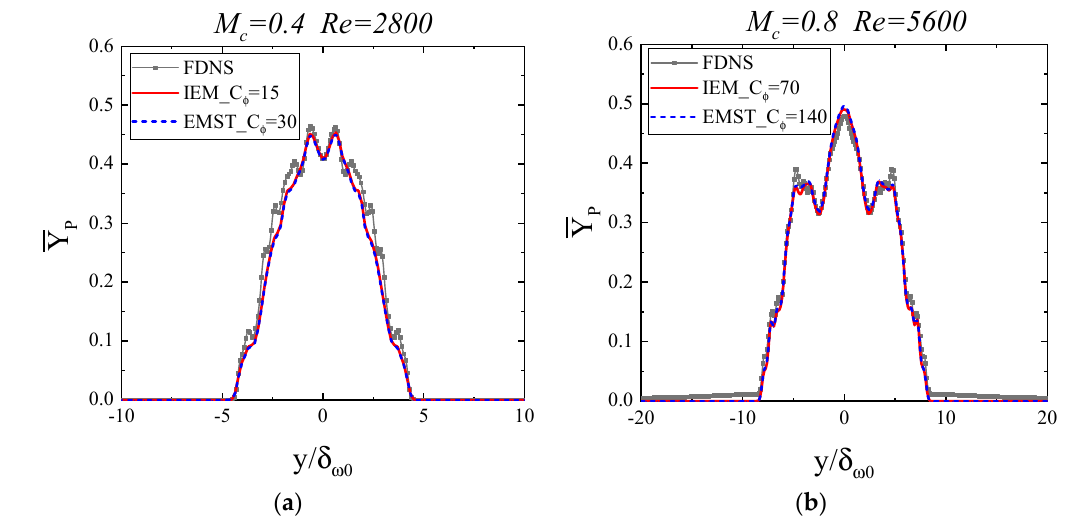
Figure 7. Cross-stream profiles of Reynolds-averaged values of the filtered product mass fraction for ( a ) M c = 0.4 case and ( b ) M c = 0.8 case, respectively.